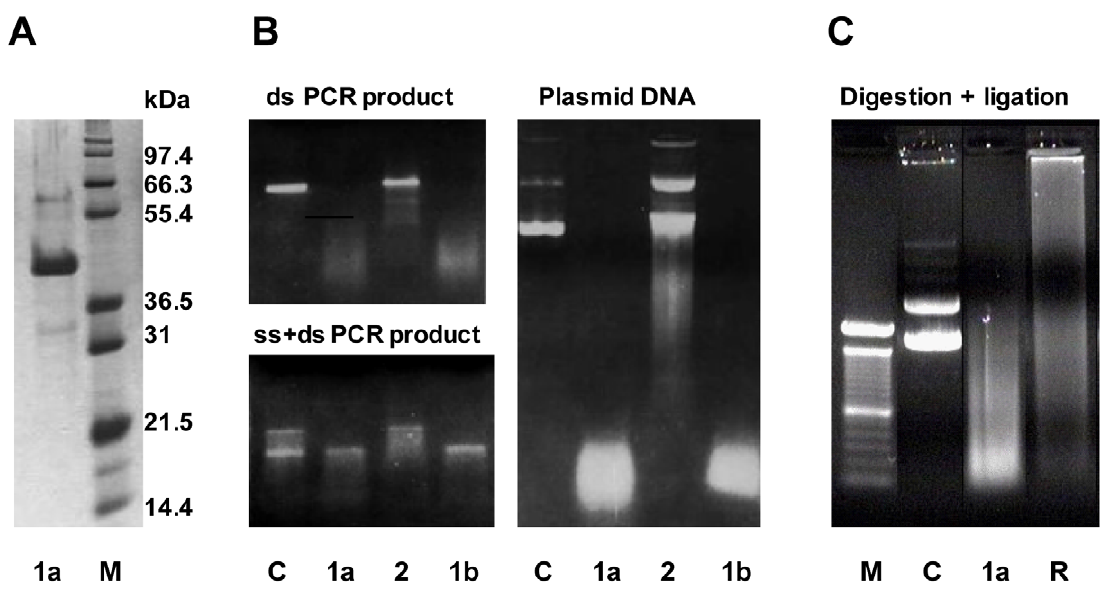
Figure 1. Purified Northern shrimp nuclease and its DNA substrates. The enzyme after SDS-PAGE and silver-staining ( A ), its hydrolyzing activity on different DNA substrates ( B ), and ligation of its digestion products ( C ) as analyzed by agarose gel electrophoresis. Activities of two preparations of the shrimp dsDNase (1a and 1b) and of a shrimp ss nuclease (2) on a dsDNA PCR product, a heat denatured PCR product (ds + ssDNA) and on supercoiled plasmid DNA are shown. M defines the lane of protein MW standards and of a 100 bp DNA ladder in the relevant gel types, and lanes C represent the respective untreated DNA substrates used. Lane R shows the ligated reaction products from dsDNase digested plasmid DNA.